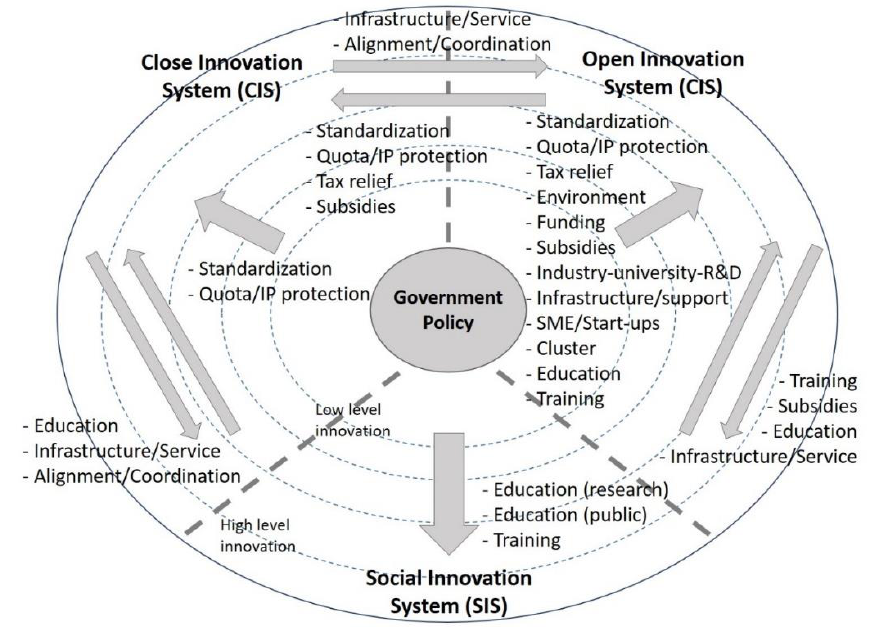
Figure 2. Macro dynamic evolution of the UK ’ s and China ’ s animation industries.